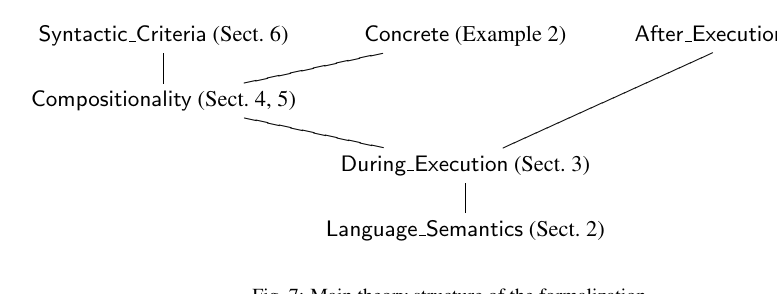
Fig. 7: Main theory structure of the